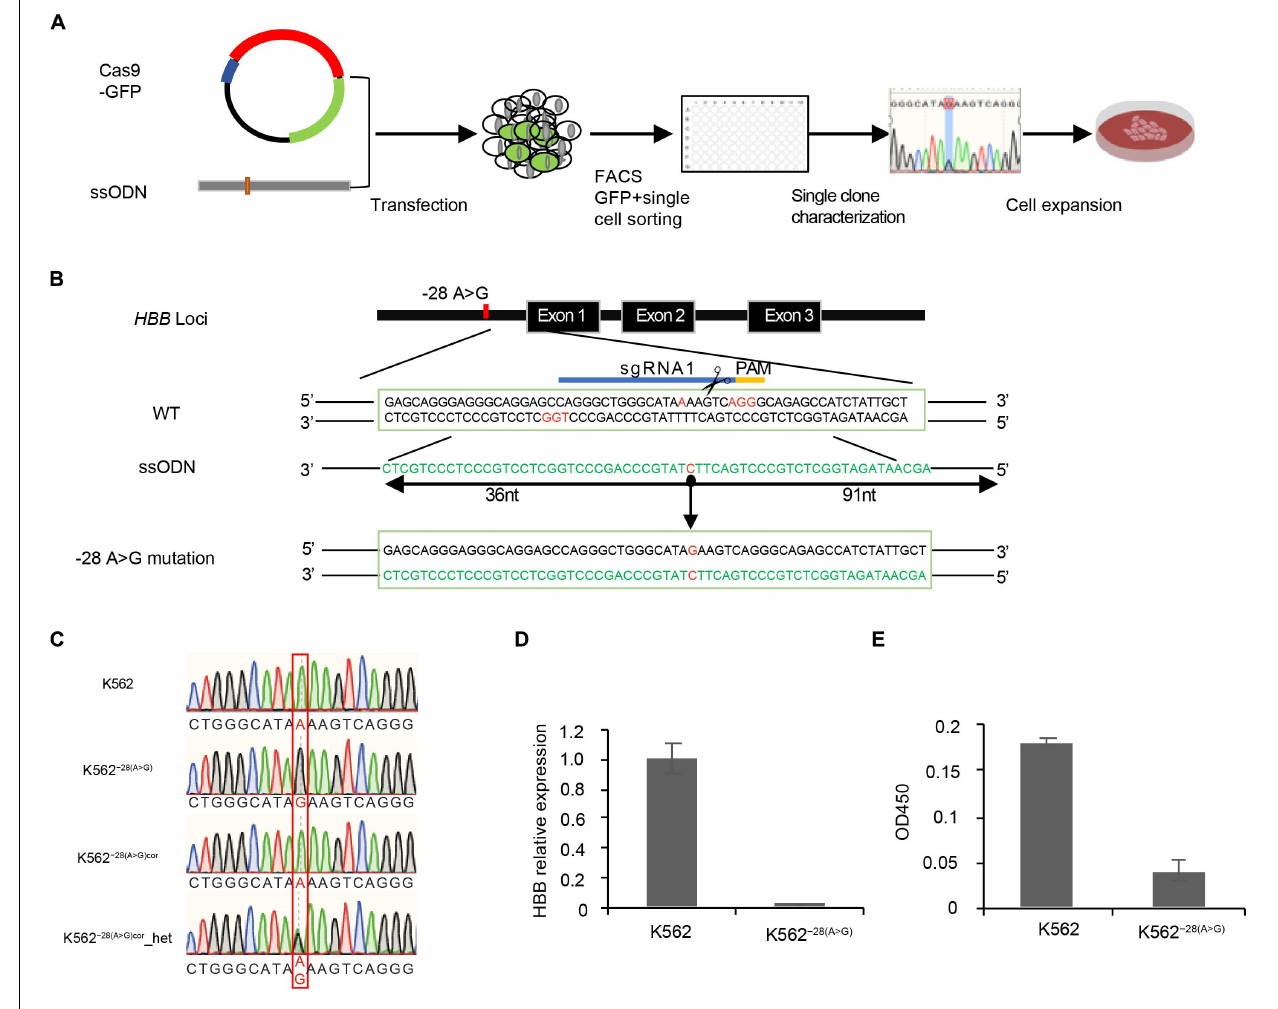
FIGURE 1 | Generation of K562 − 28 ( A > G ) cell line by CRISPR/Cas9 combined with asymmetric ssODNs. (A) Experimental diagram of generation of the HBB − 28(A > G) mutation cell line in K562. (B) The − 28 region around HBB is targeted with two sgRNAs and asymmetric ssODNs provided along with CRISPR/Cas9 DNA cleavage to generate − 28(A > G) mutation. sgRNA1 and sgRNA2 are complementary to the sense and antisense strands, respectively. sgRNA2 is not labeled but the PAM was showed in red color. Mutation site is indicated with red color in the middle of sequence. PAM: protospacer adjacent motif (orange). (C) Identification of − 28(A > G; G > A) mutation by sanger sequencing. Expected mutation is shown in the red rectangle. (D) Determination of the expression of HBB by qRT-PCR in K562 − 28 ( A > G ) and K562. (E) Determination of the expression of HBB by ELISA with benzidine staining in K562 − 28 ( A > G ) and K562.